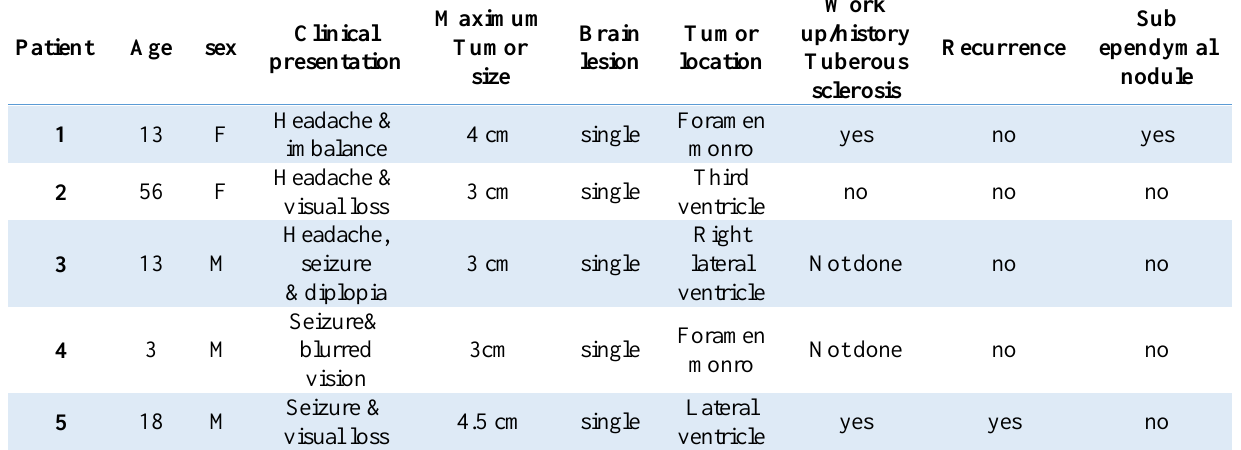
Table 1. Clinical Information of Reported Cases of Sub-ependymal Giant Cell Astrocytoma.